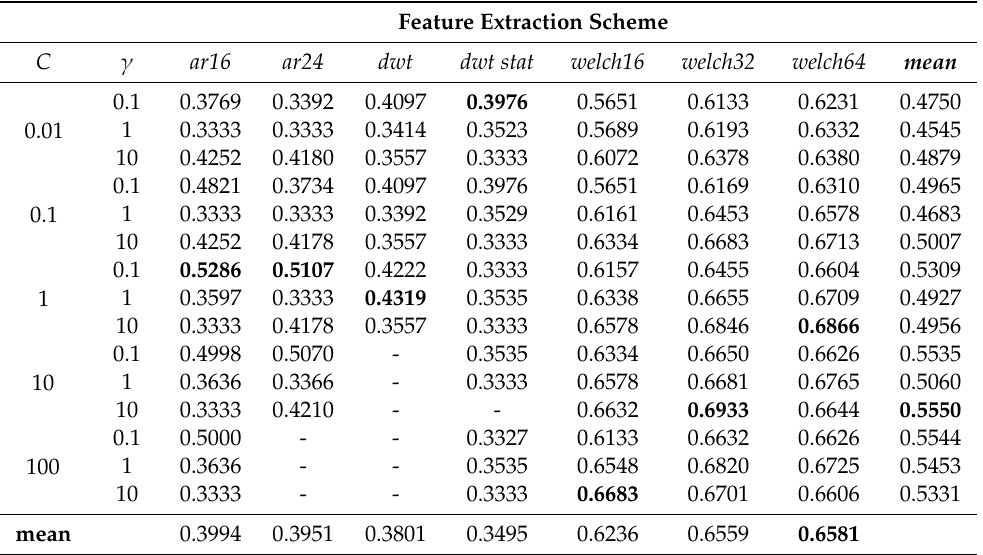
Table 15. Accuracy of test data classification with the SVM-RBF classifier for chosen values of C and γ parameters.